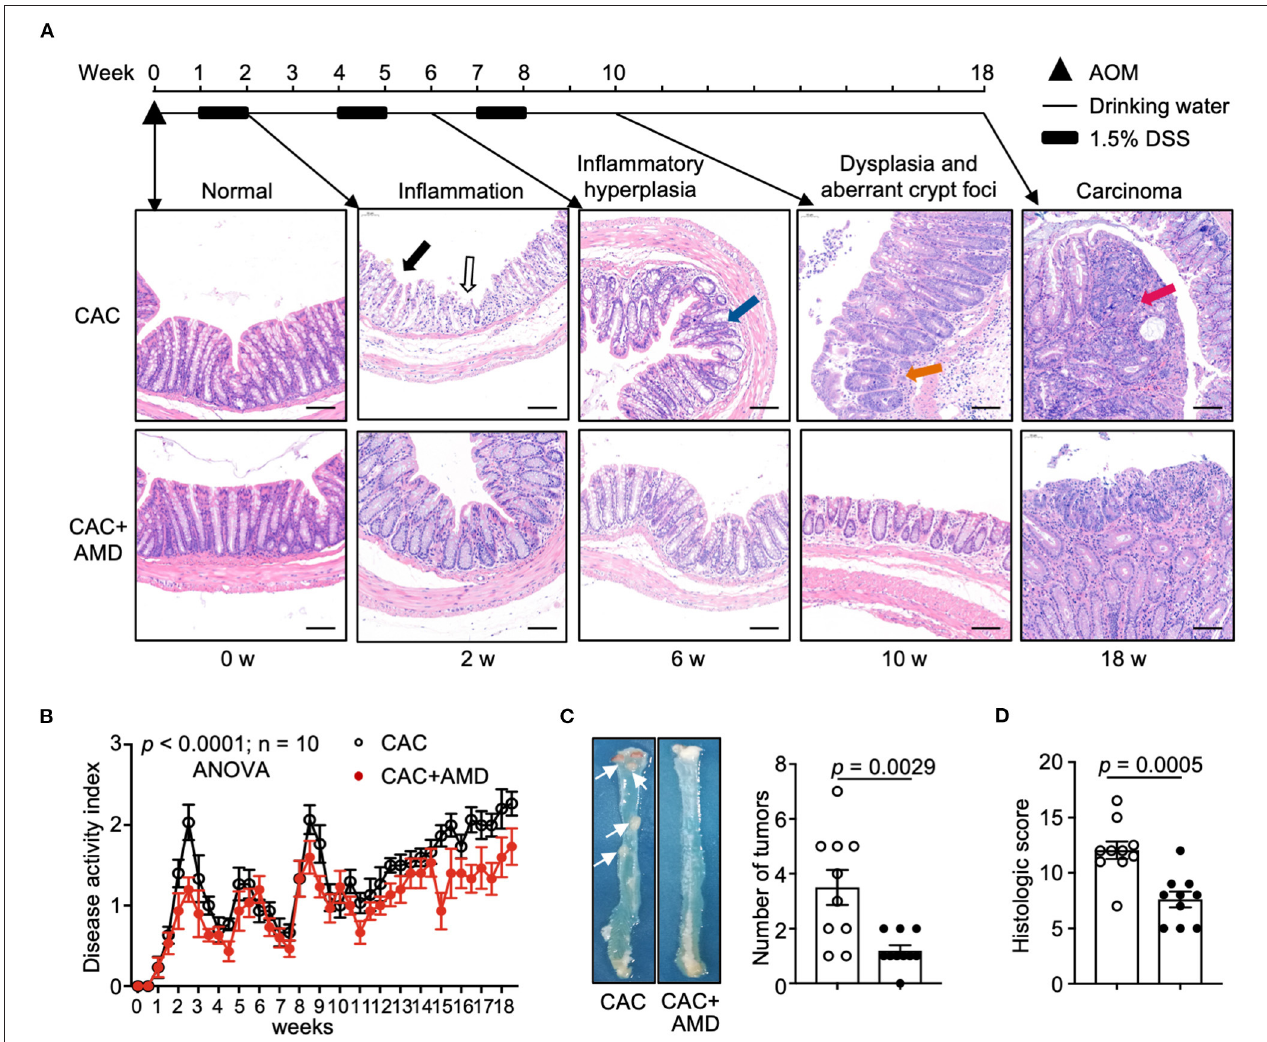
FIGURE 1 | AMD3100 inhibited AOM/DSS-induced CRC tumorigenesis. (A) Schematic representation of the experimental design and representative images of morphological observation of the colon of mice injected with PBS (CAC) or with AMD3100 (CAC + AMD) at indicated time intervals (in untreated mice and in mice from the end of 2 nd , 6, and 18 th weeks, respectively) after azoxymethane (AOM)/ dextran sodium sulfate (DSS) treatment (scale bar = 100nm, magnification 100 × ). The solid black arrow indicates colonic mucosa with a damaged epithelial barrier. The black hollow arrow indicates erosion and crypt abscesses. The Blue arrow indicates inflammatory hyperplasia in the colonic tissue with crypt distortion. The orange arrow indicates dysplasia and aberrant crypt foci. The red arrow indicates an overt carcinoma polyp in the lumen of the proximal colon. (B) Changes of disease activity index (DAI) during the treatment of AOM/DSS in mice from two groups ( n = 10). DAI = (weight loss score + stool characteristic score + hematochezia score)/3. (C) Representative gross colon morphology and the numbers of tumors were measured at the 18 th week of AOM/DSS administration ( n = 10). The white arrow indicates the overt carcinoma polyps. (D) Histopathology scores of mice in two groups in the 18 th week of treatment ( n = 10). Data are shown as Mean ± SEM (B) or Mean ± SD. Statistical analysis was carried out using Two-way ANOVA with Geisser-Greenhouse correction and multiple unpaired t